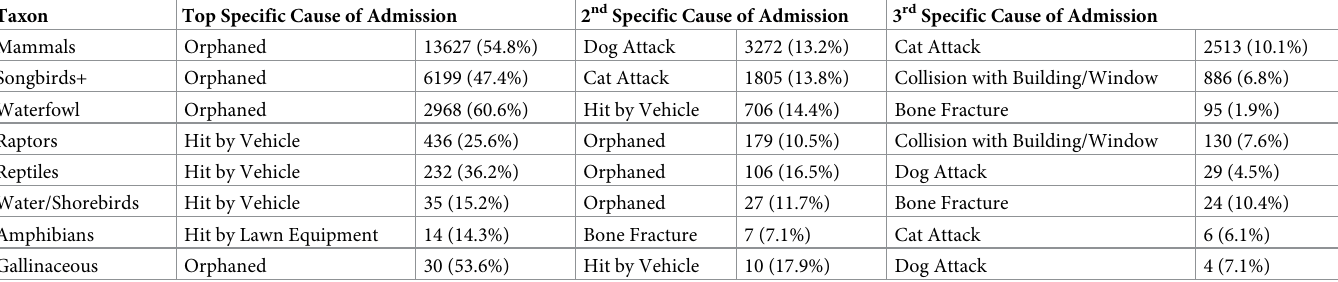
Table 3. The top three specific causes of admission for each taxonomic group, with total count and percentage of taxon individuals admitted due to each cause, release rate, and